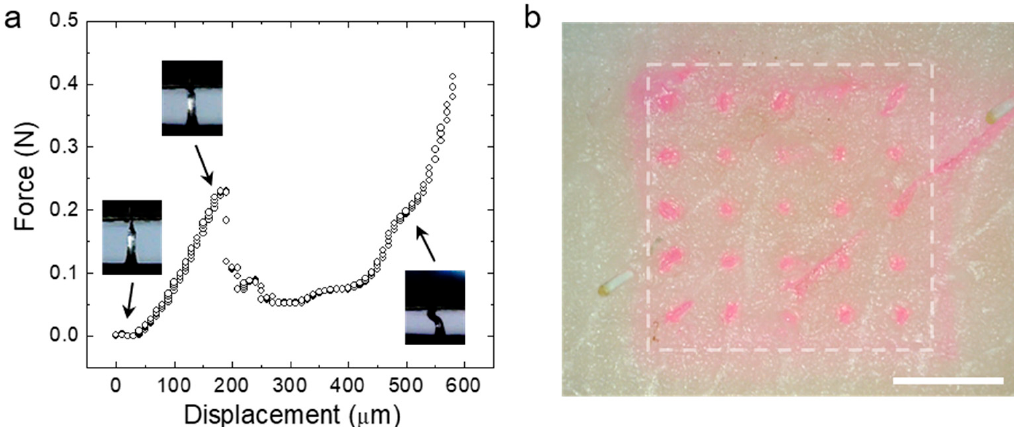
Figure 4. ( a ) The force displacement profile obtained from the axial compression test of the single CS MN. Snapshot images showing the response for the CS MN corresponding to the displacement point. ( b ) The photo image of the pig skin after the insertion test using the rhodamine dye-loaded CS MN array (Scale bar; 2 mm).